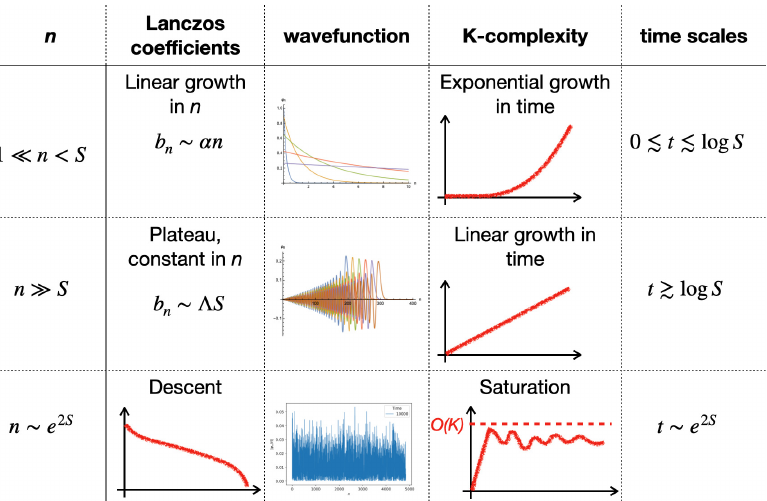
Figure 1. This table summarizes the general behaviour expected from K-complexity, particularly for finite chaotic systems with S degrees of freedom ( Λ is the bandwidth of the system). It is based on [3, 4] and